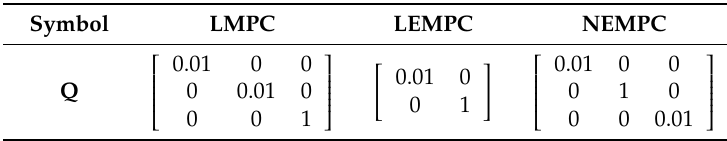
Table 5. Changed parameters in controllers.